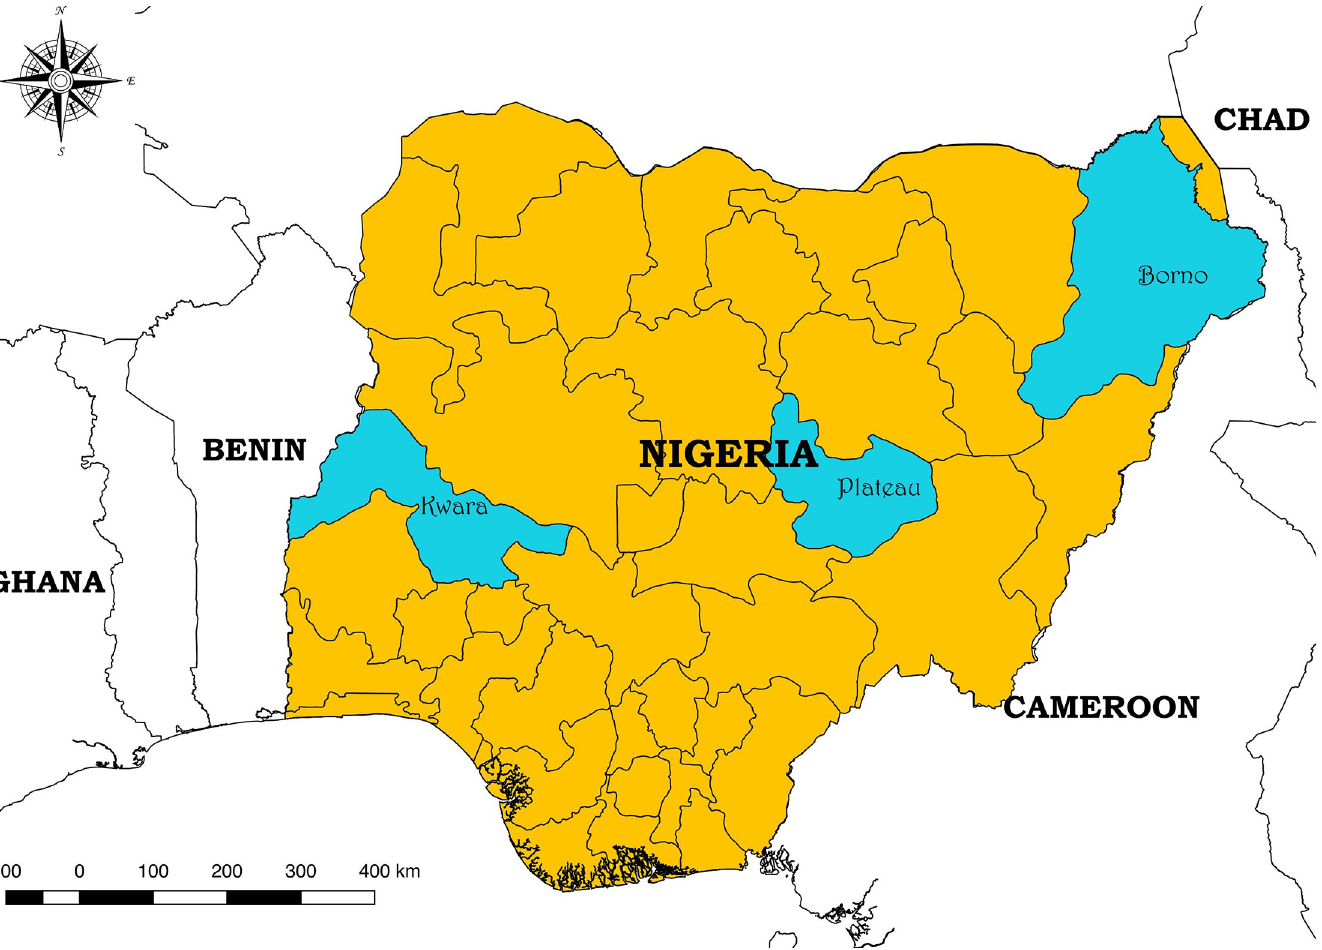
Fig 1. Map of Nigeria (within West Africa), showing the three northern states (Kwara, Plateau and Borno) where cattle and small ruminants were